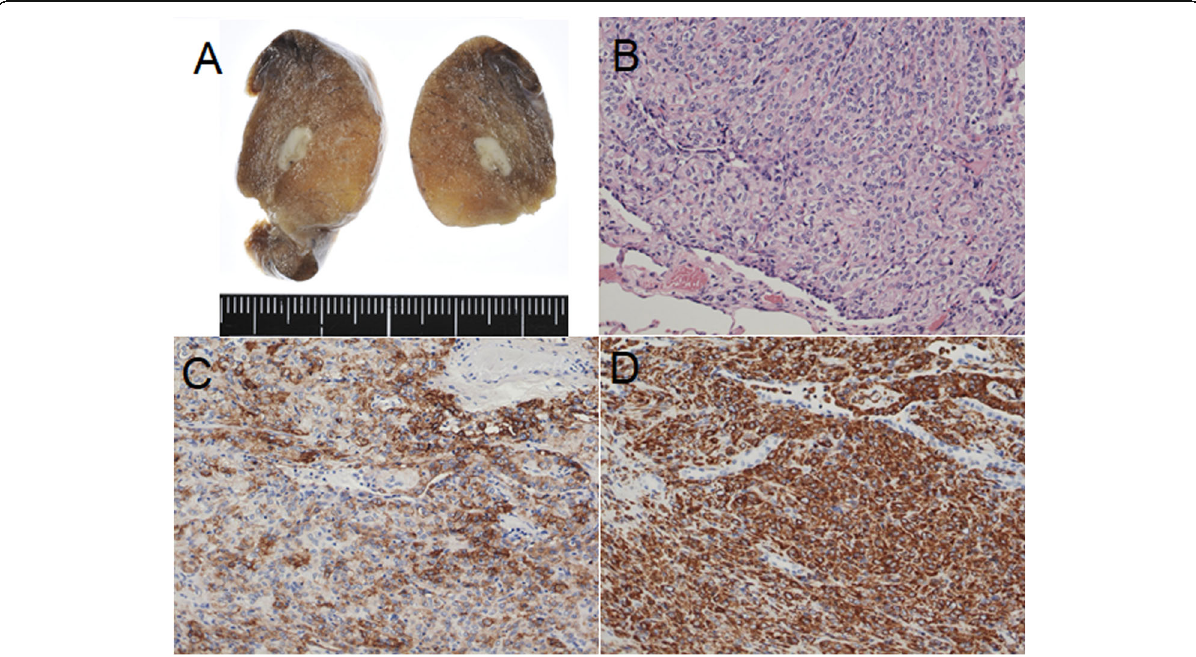
Fig. 2 a A gross finding of the surgical specimen revealed a well-circumscribed white nodule measuring 8 mm. b The neoplastic cells with oval nuclei are arranged in sheets (hematoxylin and eosin stain). c The neoplastic cells were positive for epithelial membrane antigen, d and